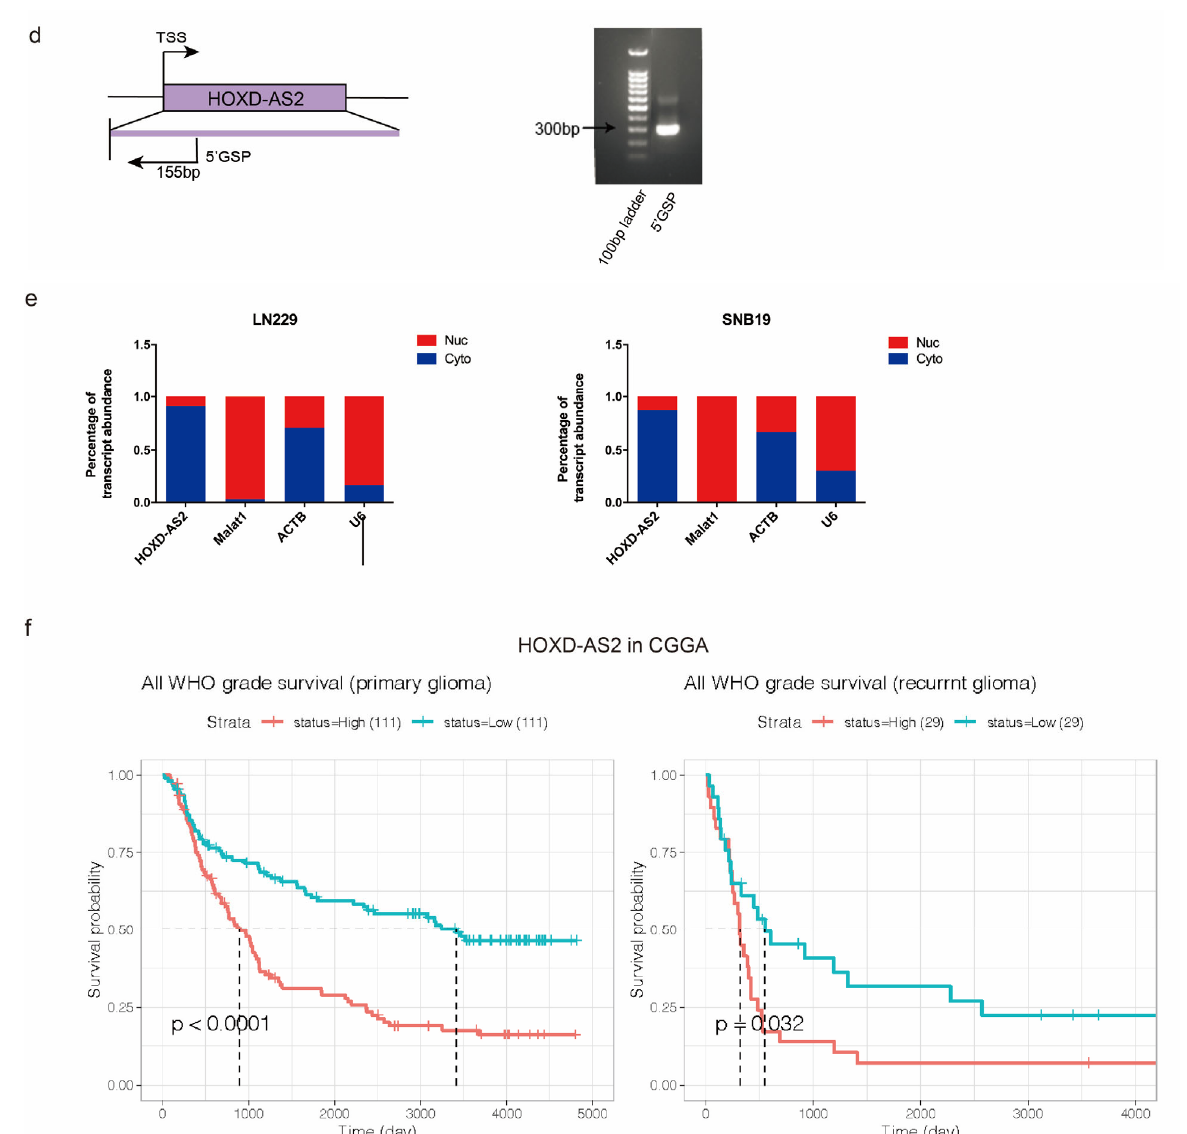
Figure 1. HOXD ‐ AS2 is up ‐ regulated in gliomas and correlated with prognosis. ( a ) UCSC database showed the expression of HOXD ‐ AS2 in normal tissues (http://genome.ucsc.edu, accessed on 23 January 2022). ( b ) The expression of HOXD ‐ AS2 in different cancer types analyzed by TCGA and GTEx database. The p ‐ values were calculated using a Wilcoxon test by R (version 4.0.5). Significant results were presented as * p < 0.05, ** p < 0.01, *** p < 0.001, **** p < 0.0001. ( c ) Pattern diagram of the specific primers for HOXD ‐ AS2 three transcripts (left). Relative expression of HOXD ‐ AS2 in astro ‐ cyte cell lines, glioblastoma cell lines and glioma stem cell lines were quantified by RT ‐ qPCR (right). ( d ) HOXD ‐ AS2 full ‐ length identification by 5 ′ RACE. ( e ) Detecting the expression of HOXD ‐ AS2 in cytoplasm and nucleus by RT ‐ qPCR. MALAT1 , ACTB and U6 as positive controls. ( f ) Kaplan–Meier survival analysis of OS in GBM patients based on HOXD ‐ AS2 expression in CGGA (Mantel–Cox test).